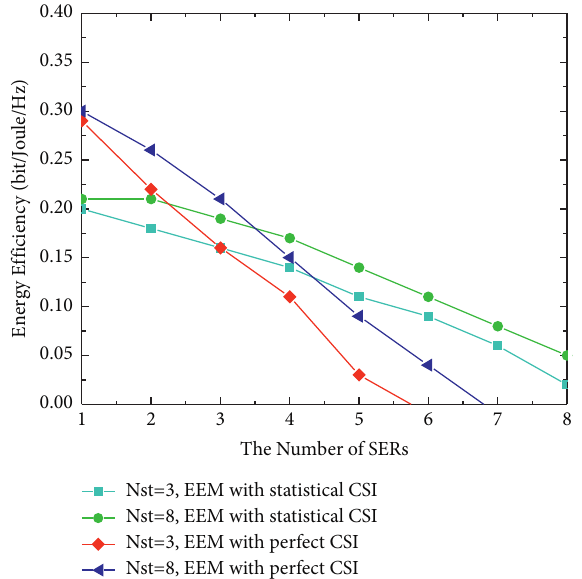
Figure 5: The achievable EE versus the quantity of SERs by varying the number of transmitting antennas at